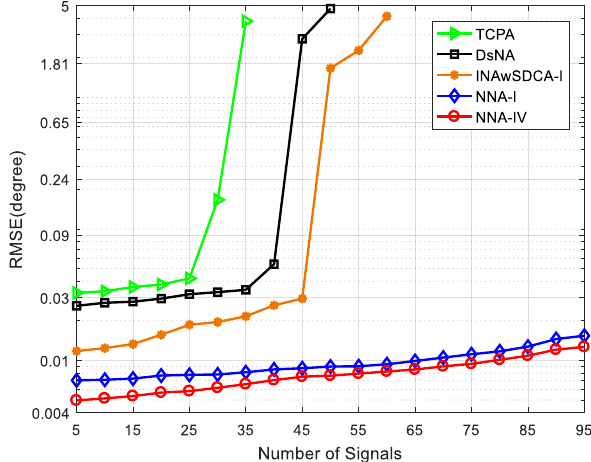
Figure 6. RMSE results of five di ff erent sparse arrays versus the number of signals, where the number of sensors is fixed to be 10, SNR = 0 dB, and N s = N p = 800 .